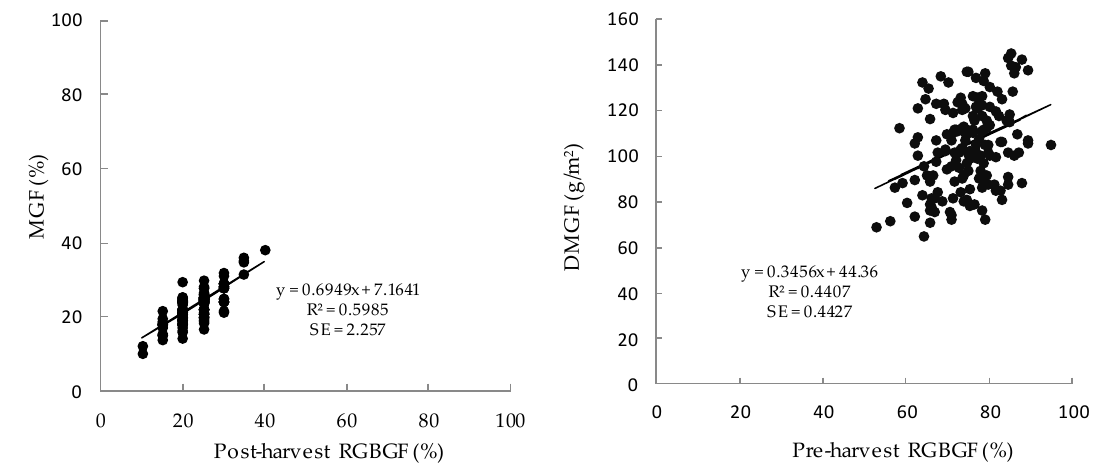
Figure 7. Linear regression models for green fraction prediction, n = 162, where RGBGF is RGB image-based green fraction, MGF is manual green fraction, and DMGF is the dry matter of the green fraction.